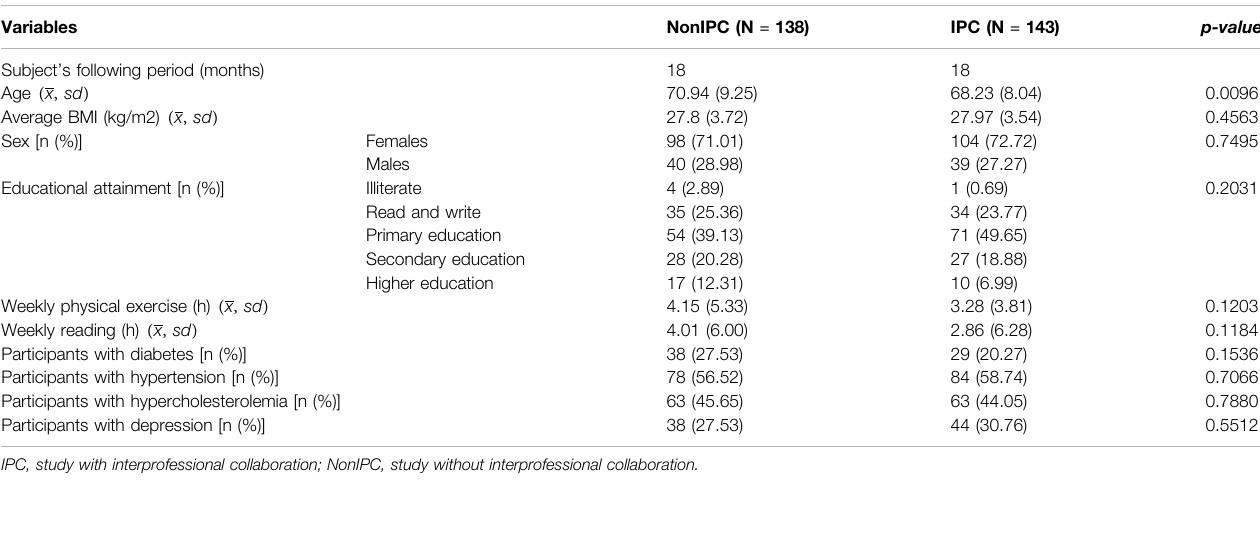
TABLE 3 | Description of quantitative variables in both groups.